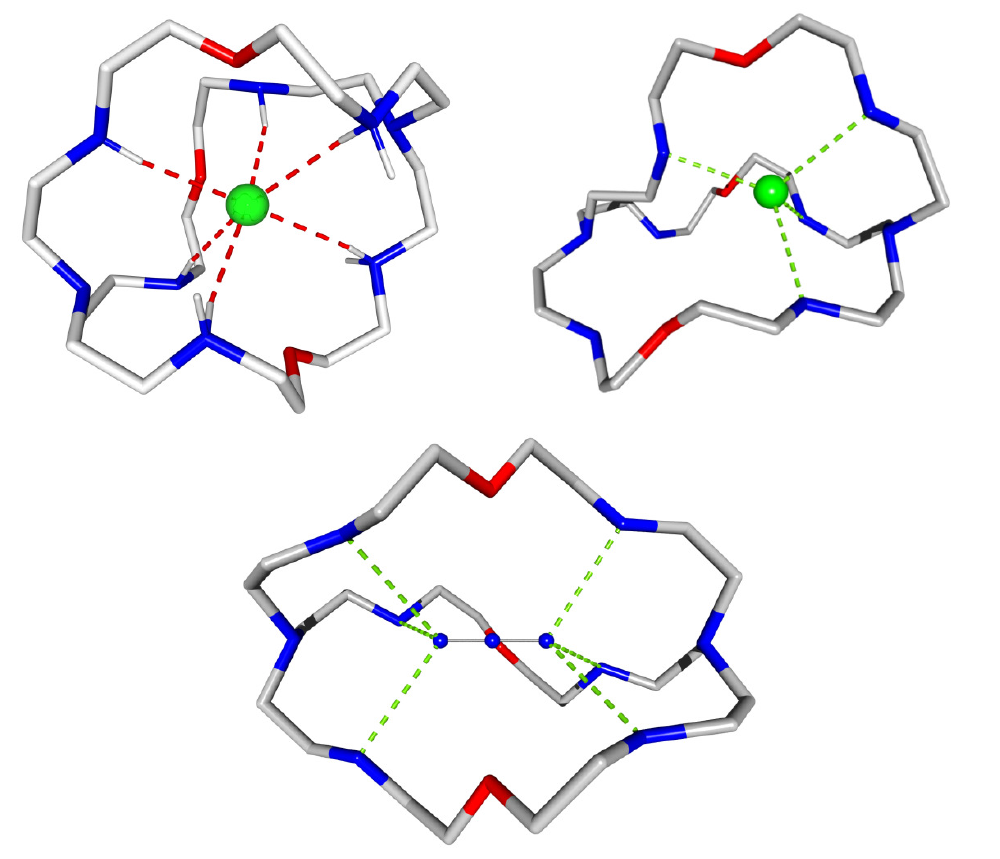
Figure 2. Depiction of the binding of chloride (left), fluoride (right) and azide (bottom) anions by the hexaprotonated macrobicyclic receptor bis-tren-6H + . Anions are encapsulated by the receptor through secondary ammonium hydrogen bonds with shape-dependant